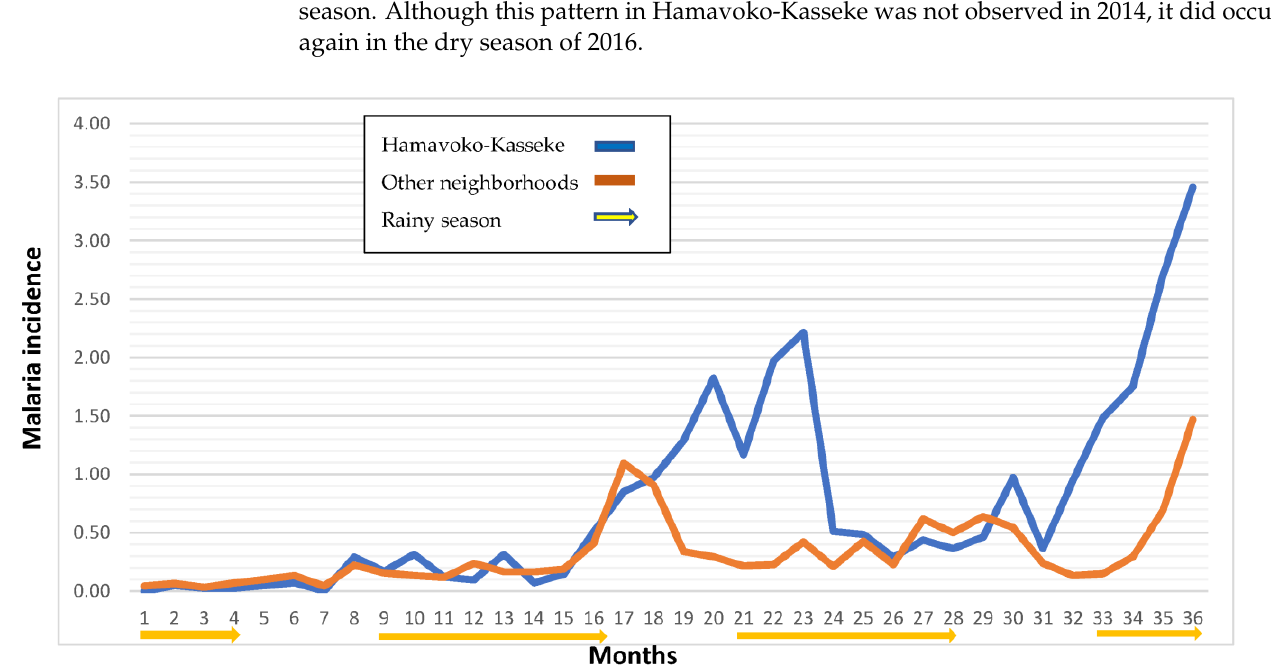
Figure 5. Incidence rate of malaria (cases per 1000 population) in the Hamavoko-Kasseke neighborhood compared to other neighborhoods (January 2014–December 2016).